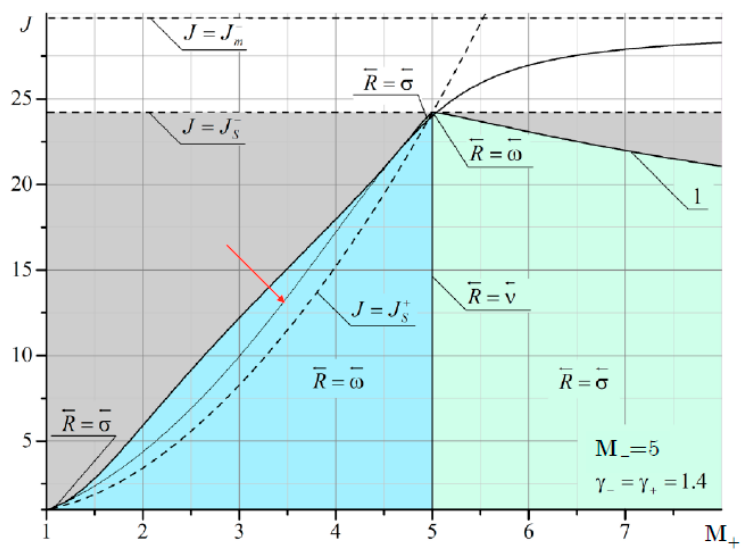
Figure 13. Domains of existence of various types of hydrocarbons formed during refraction of a shock with intensity J , propagating from a flow with a Mach number of M – = 5 to a flow with a Mach number of M + .